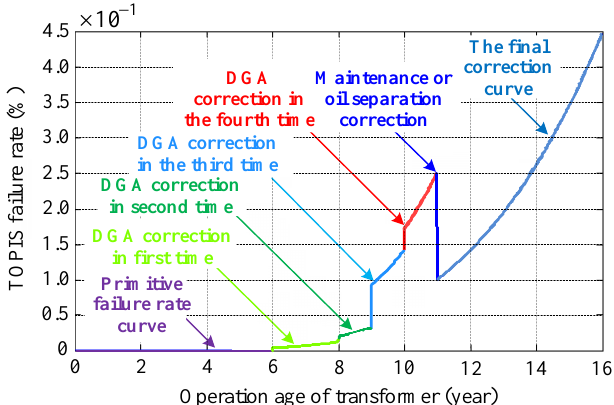
Figure 13. The original failure rate curve of TOPIS.